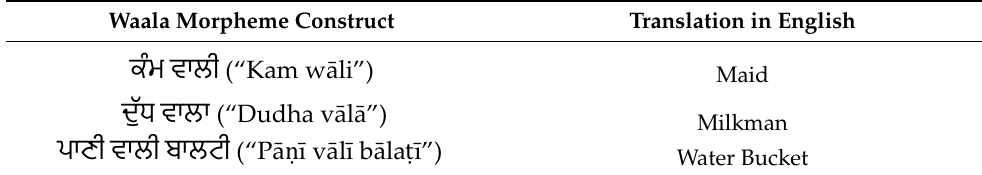
Table 3. The waala morpheme constructed in Punjabi.